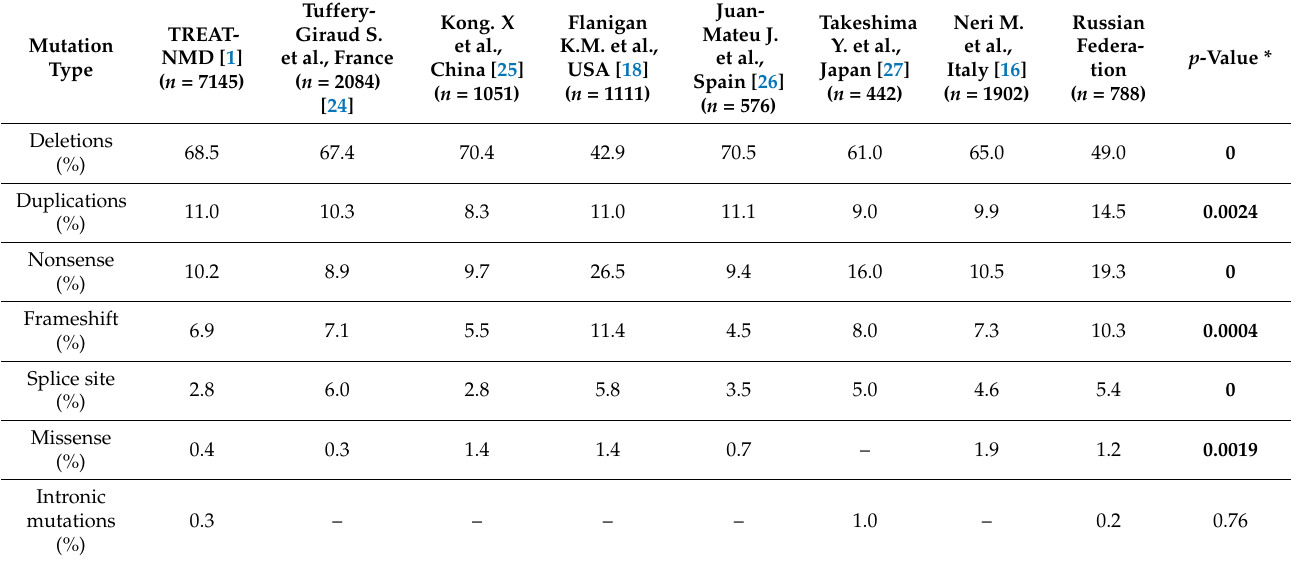
Table 2. Comparison of various DMD mutation rates in DMD/BMD patients from the Russian Federation and other